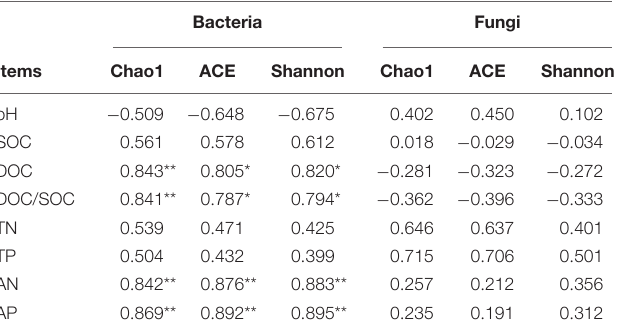
TABLE 4 | Correlations between soil properties and microbial richness and diversity indices. Bacteria Fungi